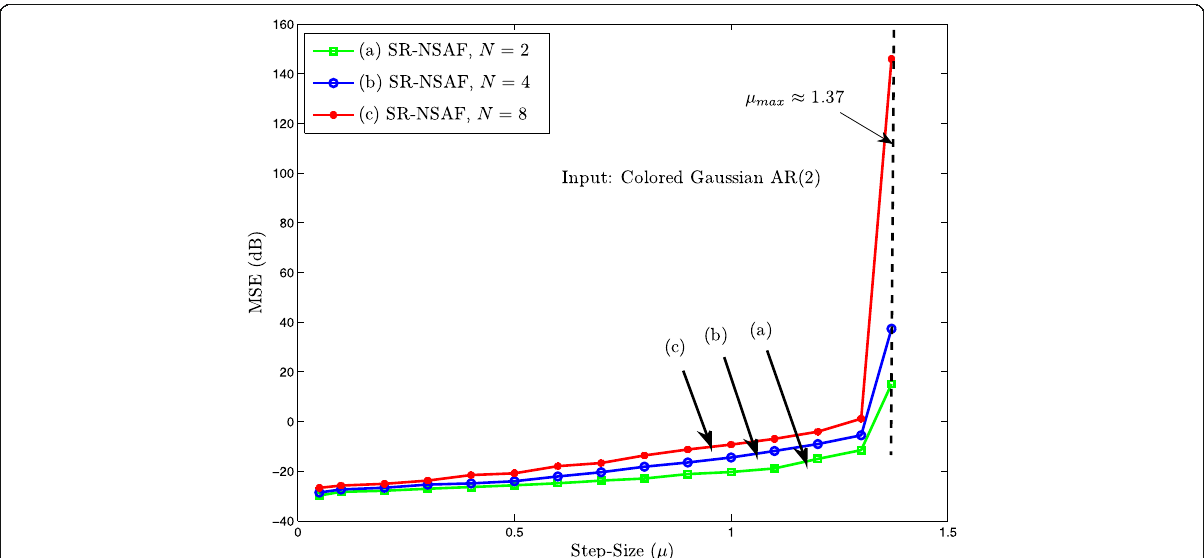
Fig. 24 Simulated steady-state MSE of SR-NSAF with N = 2, 4, and 8 as a function of the